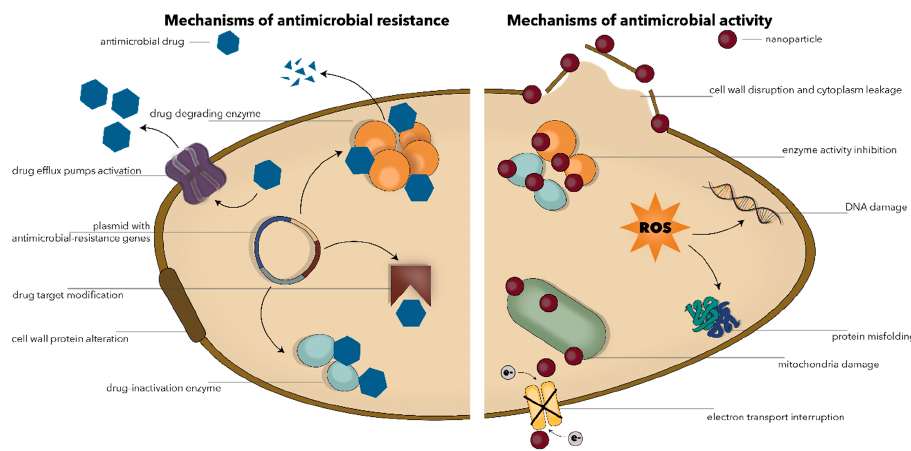
Figure 1. Schematic representation of the main mechanisms involved in the antimicrobial resistance ( left ) and the antimi- crobial activity of nanoparticles ( right ).